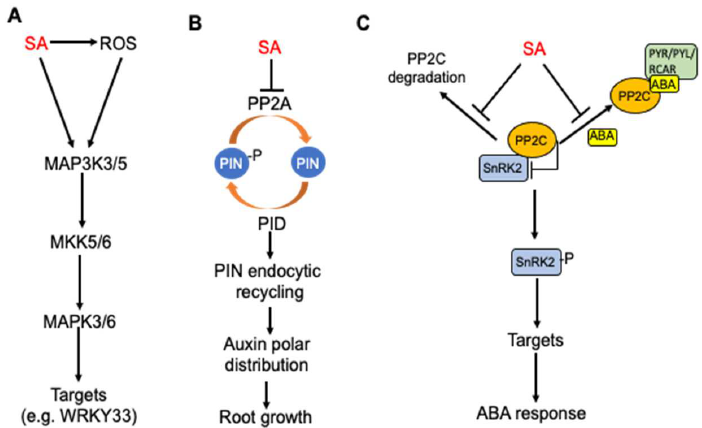
Figure 3. Regulation of protein phosphorylation networks by SA in plants. ( A ) SA-induced MAPK signaling cascade for regulation of defense responses. ( B ) SA inhibition of root growth through inhibition of PP2A, endocytic recycling and polar distribution of auxin. ( C ) SA antagonism of ABA signaling through inhibition of PP2C degradation and ABA-stimulated interaction of PP2C and ABA receptors.